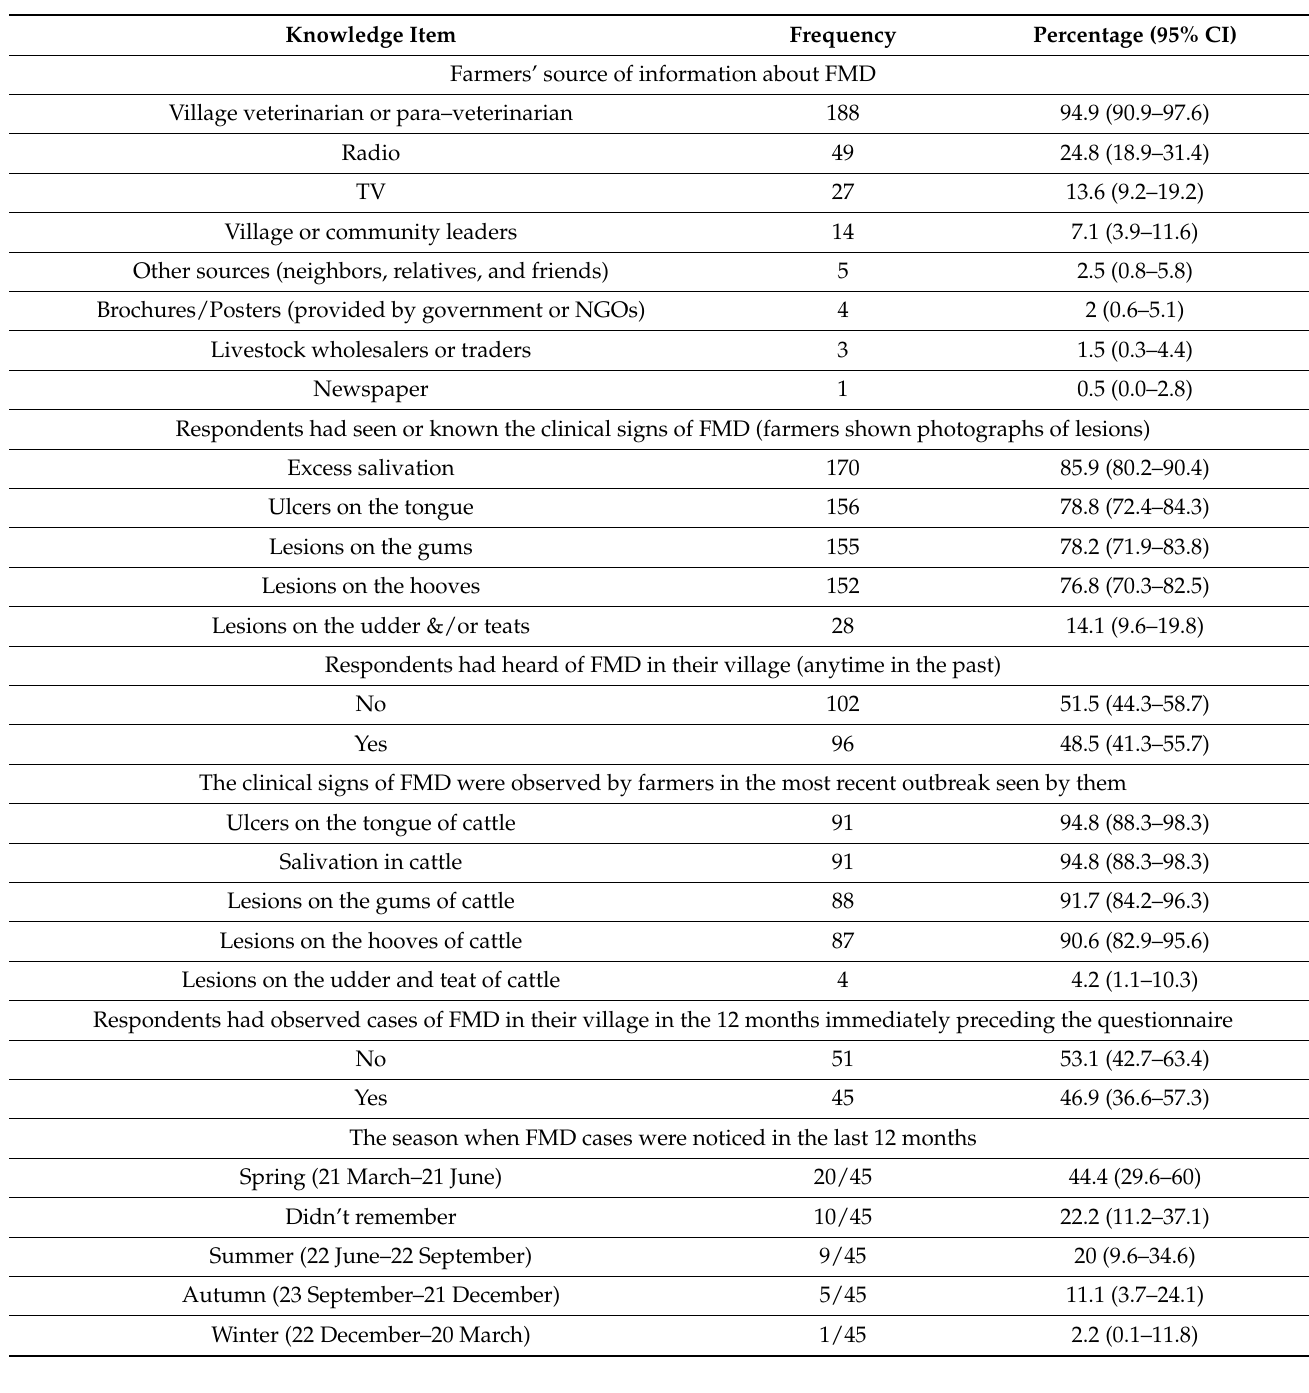
Table 1. Knowledge and awareness of 198 farmers from Baghlan Province, Afghanistan, about foot and mouth dis- ease